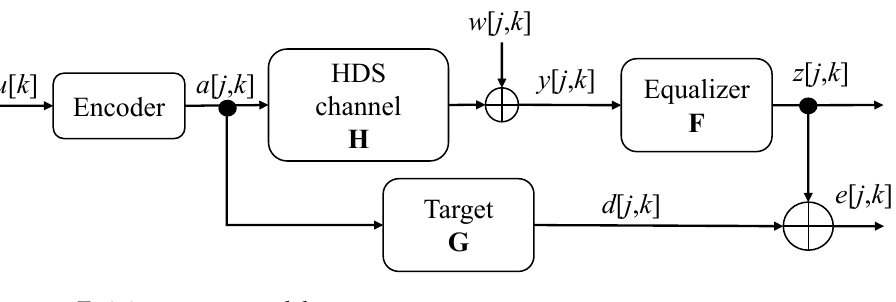
Figure 1. Training process model.